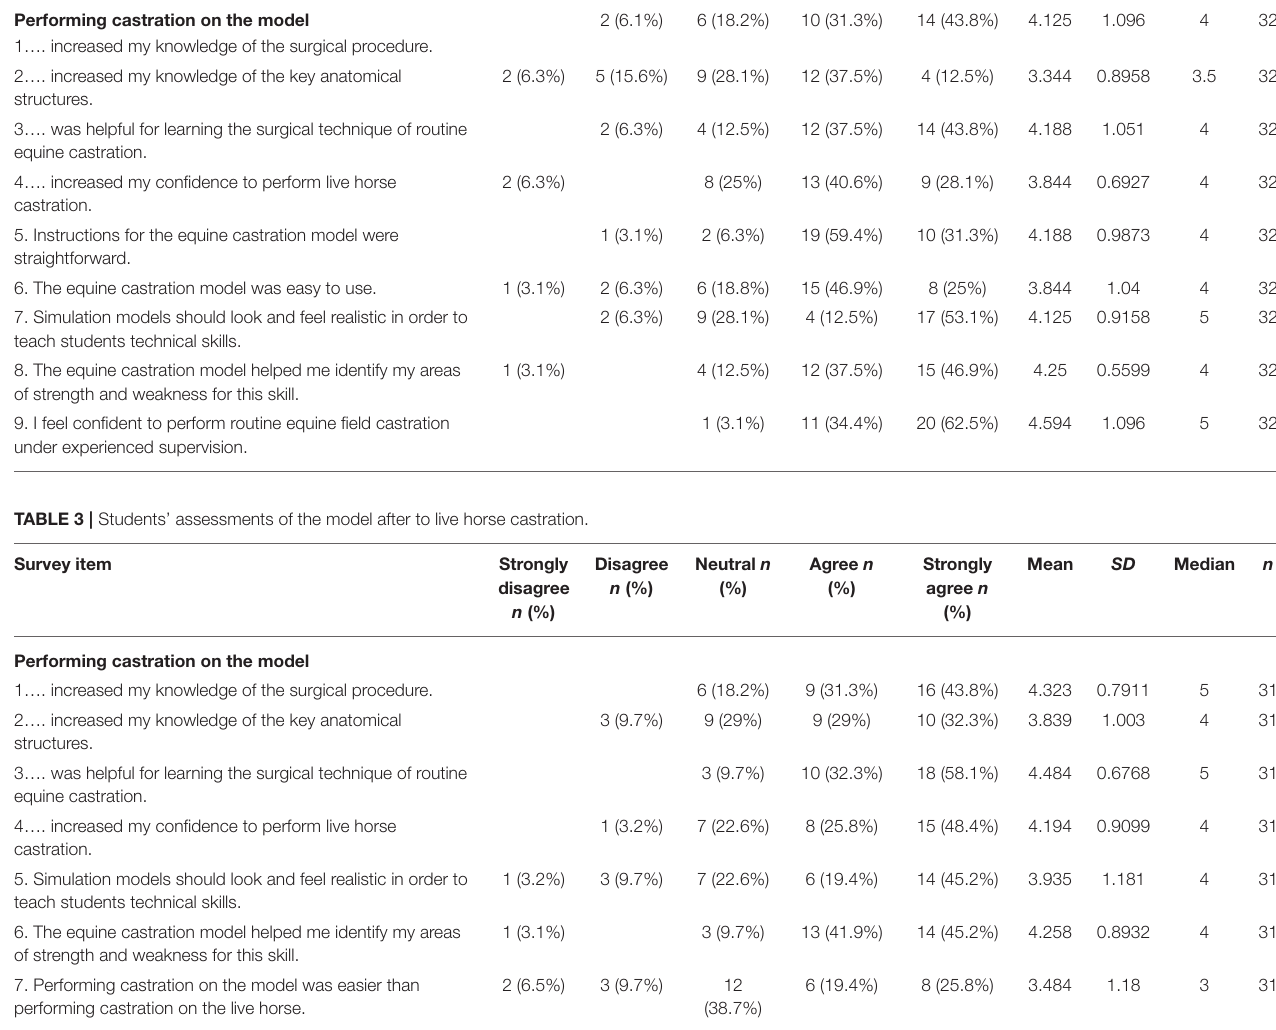
TABLE 2 | Student assessment of the model prior to live horse castration. Survey Strongly Disagree Neutral Agree Strongly Mean SD Median n item disagree Performing castration on the model